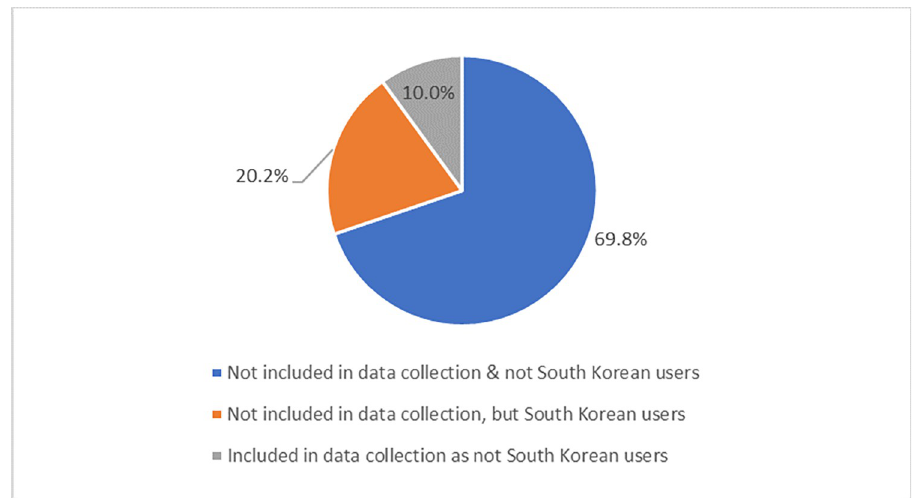
Fig 3. Reasons why tweets were not covered by our